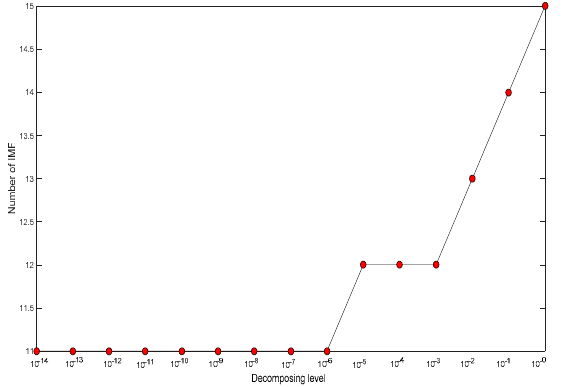
Figure 22. Decomposition number corresponding to each decomposition level.